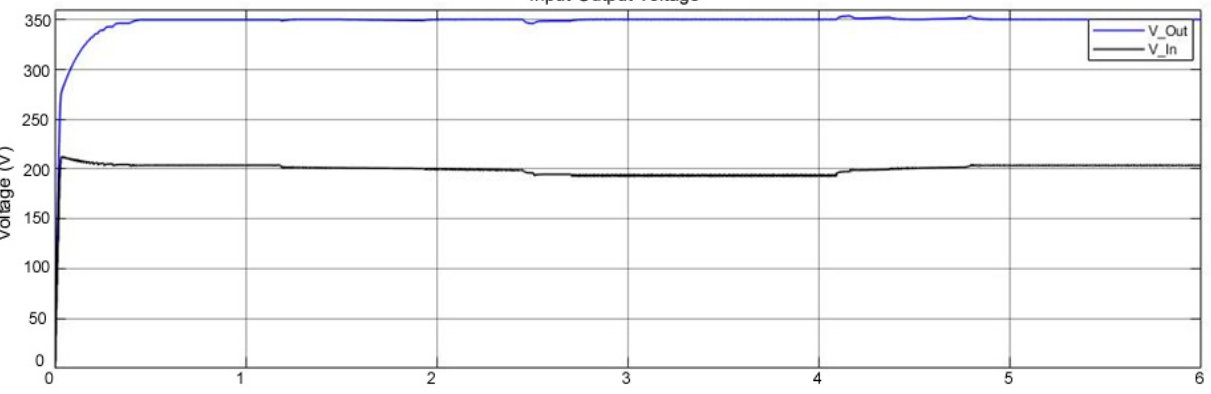
Figure 7. Input and output voltages of two − phase IBC with EKF MPPT.